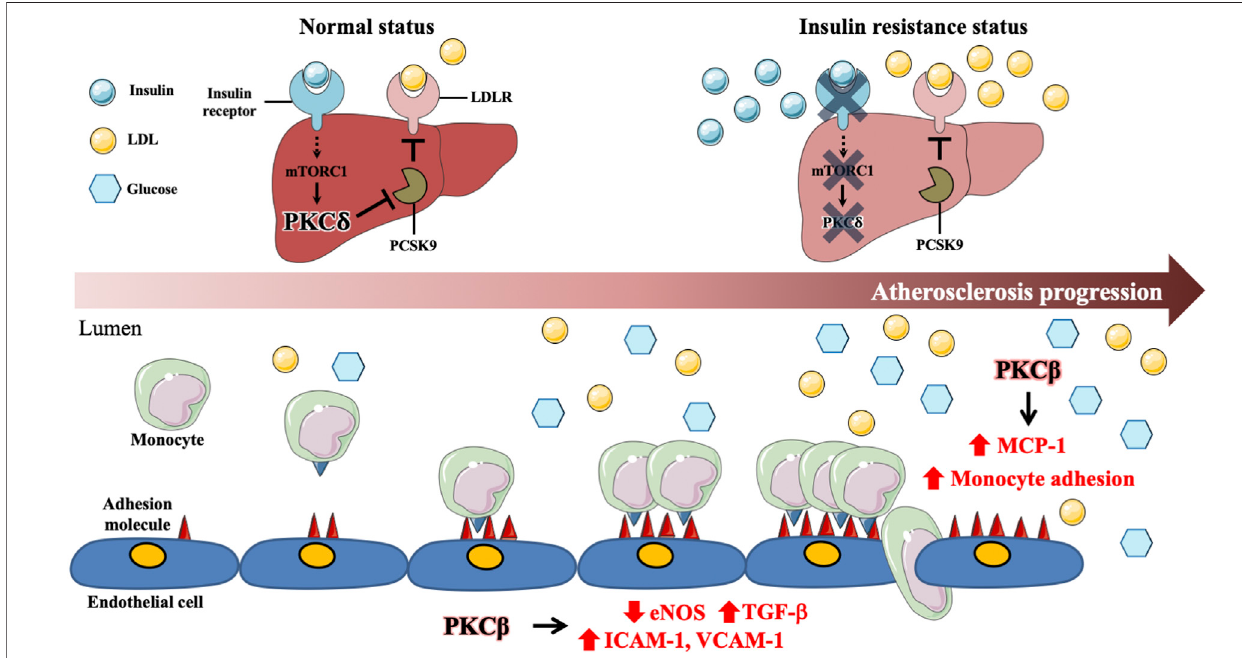
FIGURE 2 | Involvement of speci fi c protein kinase C isoform in diabetes-associated atherosclerosis. In the normal status, activated insulin signaling enhances PKC δ through mTORC1 signaling pathway in hepatocytes. Activated PKC δ maintains LDLR protein expression by inhibiting expression of proprotein convertase subtilisin/kexin type 9 (PCSK9). Under insulin resistance status, impaired insulin signaling results in suppression of mTORC1 and PKC δ expressions, which enhances PCSK9 expression and promotes LDLR degradation, contributing to diabetes-associated dyslipidemia. Hyperglycemia activates PKC β to decrease eNOS activity and increase TGF β expression, which enhances adhesion molecules, such as ICAM-1 and VCAM-1, expression in ECs. Moreover, Hyperglycemia further promotes macrophage in fl ammation and adhesion to ECs via PKC β activation. Those data reveal that PKC δ and PKC β play central roles in diabetes-associated atherosclerosis.